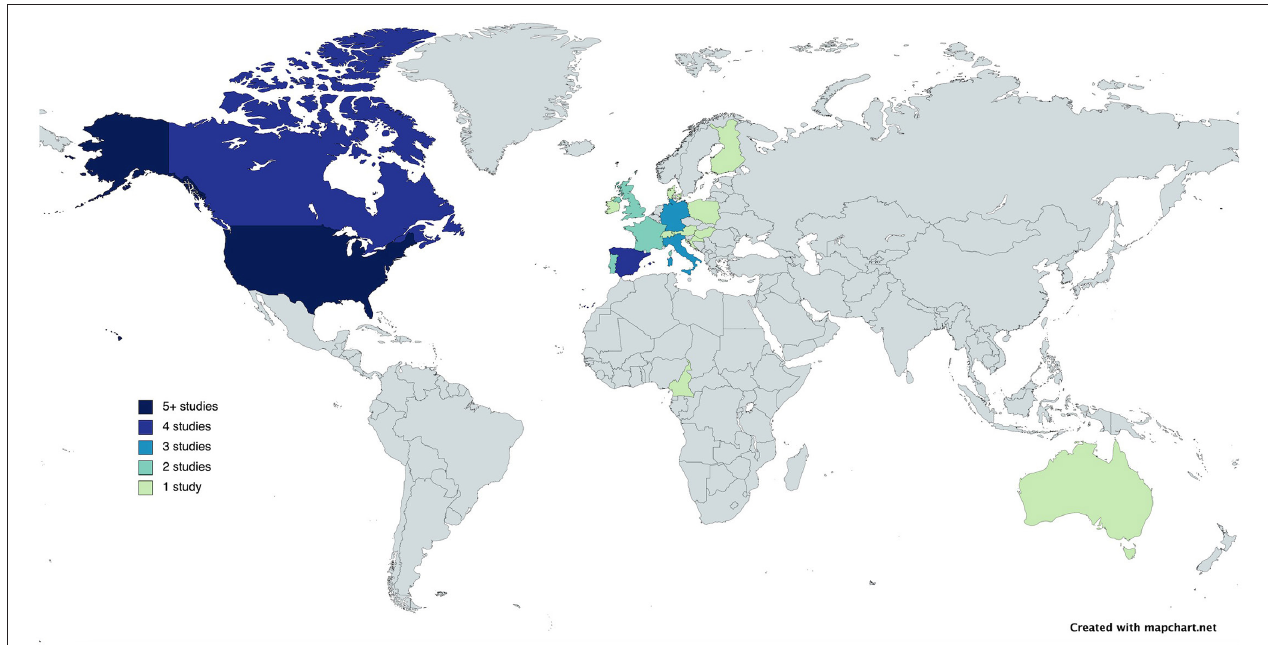
FIGURE 1 | World map depicting the number of studies (color) on stroke symptoms in women and men were conducted.